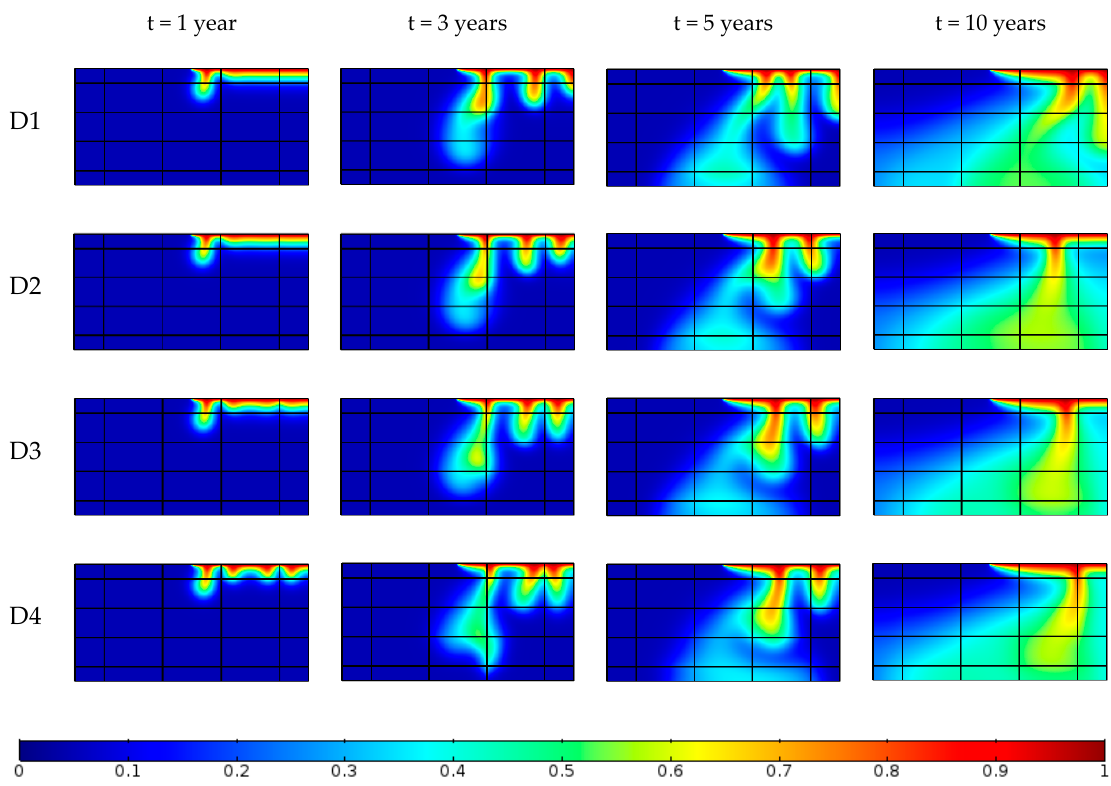
Figure 9. Solute distribution of half of domain of scenario (D) for different fracture aperture at simulation times of 1, 3, 5 and 10 years. The fracture aperture from D1 to D4 increases.